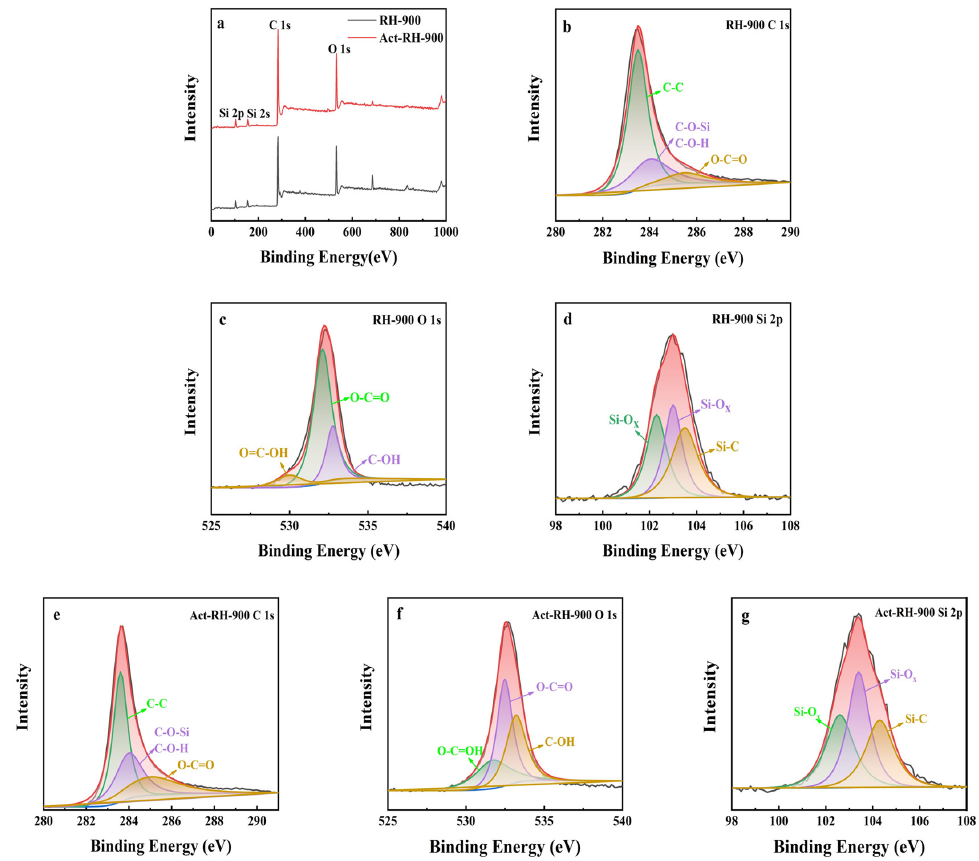
Table 1. Composition of RH-900 and Act-RH-900 samples (atomic